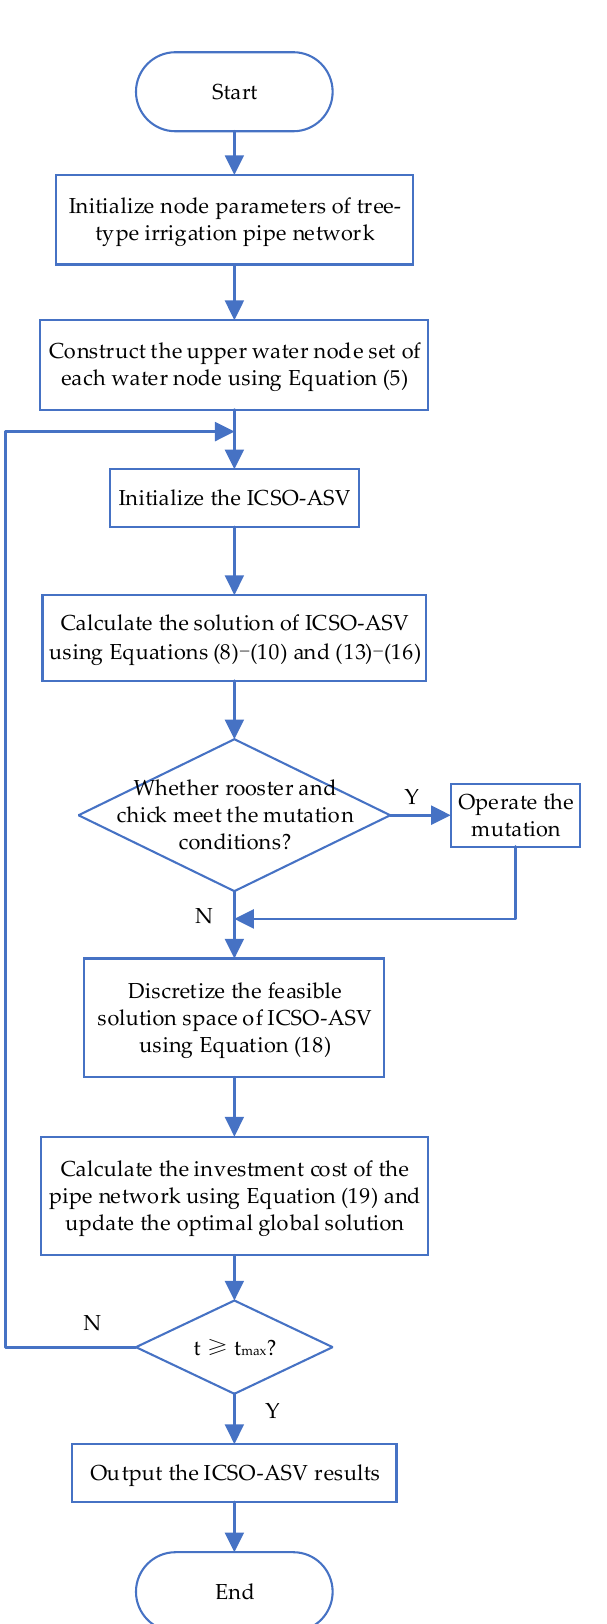
Figure 3. Flowchart of an irrigation pipe network design based on the ICSO-ASV algorithm.